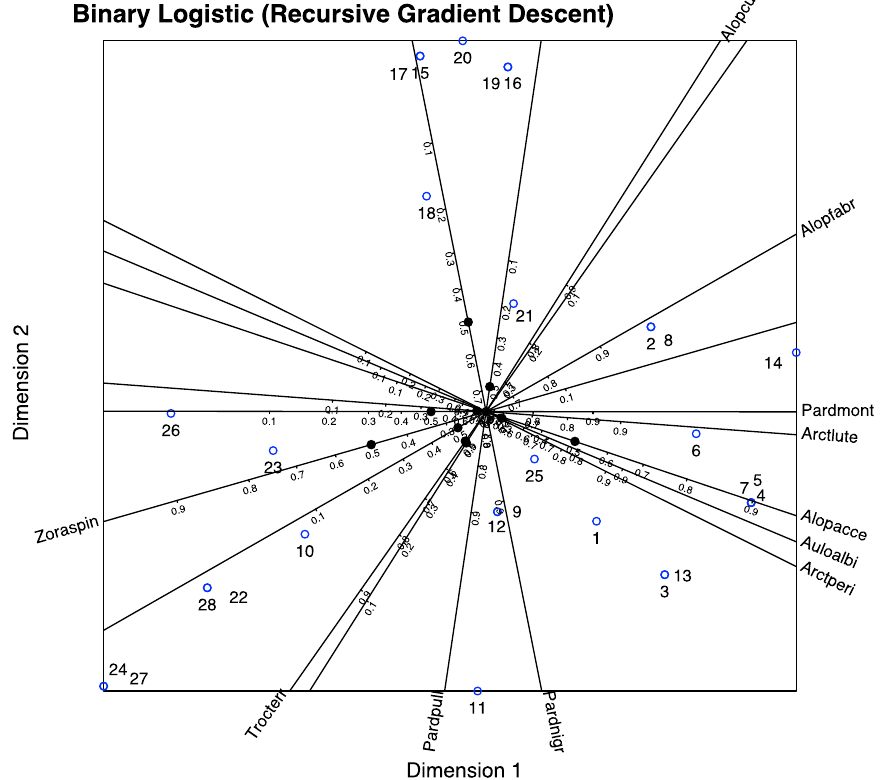
Figure 3. Typical logistic biplot representation with graded scales for the binary variables. The data used for the biplot are the binary matrix of the second example in the next